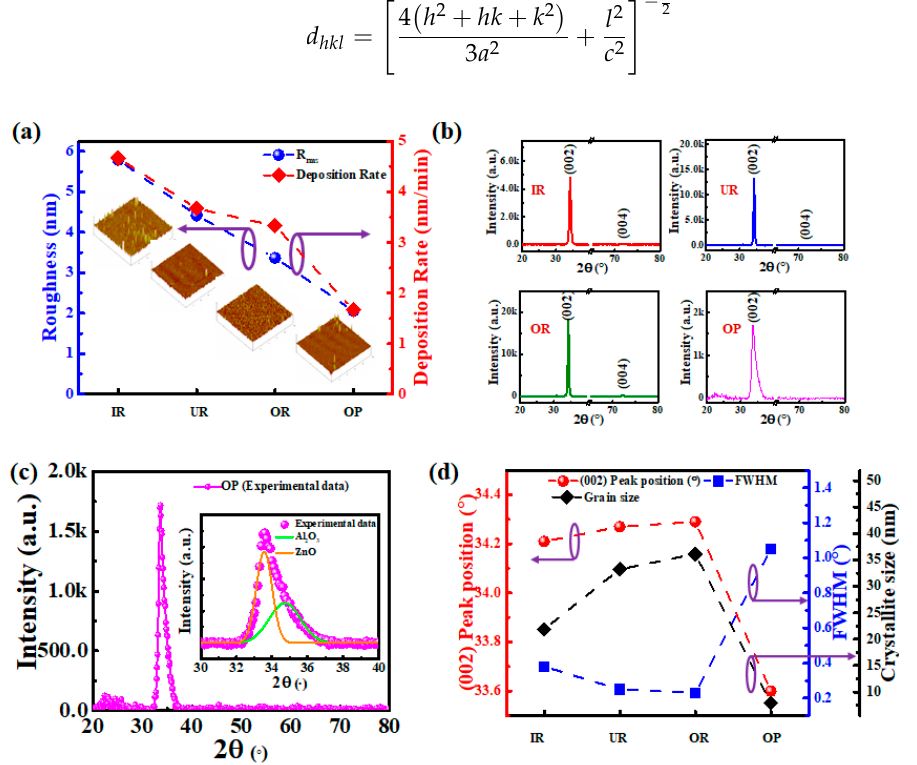
Figure 2. SLG substrates at different locations relative to target material, with the deposited AZO film characteristics as follows: ( a ) deposition rate and AFM measurements; ( b ) XRD measurements; ( c ) XRD magnified fitting results at location OP; ( d ) position shift of (002) plane main peak and calculations of FWHM and crystallite size.